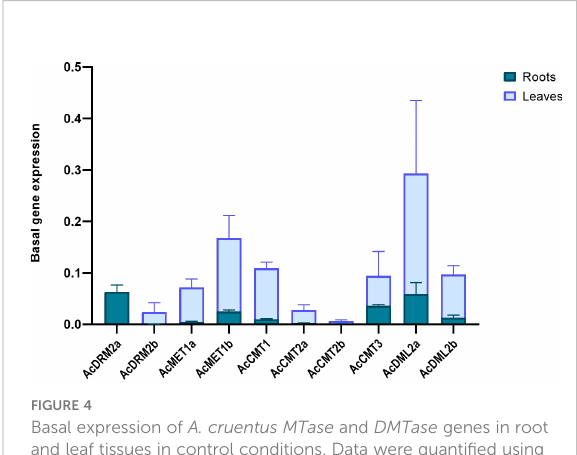
FIGURE 4 Basal expression of A. cruentus MTase and DMTase genes in root and leaf tissues in control conditions. Data were quanti fi ed using the 2 − DD Ct method based on Ct values of A. cruentus MTase and DMTase genes and tubulin. Error bars indicate the mean ± SD (standard deviation) of three biological